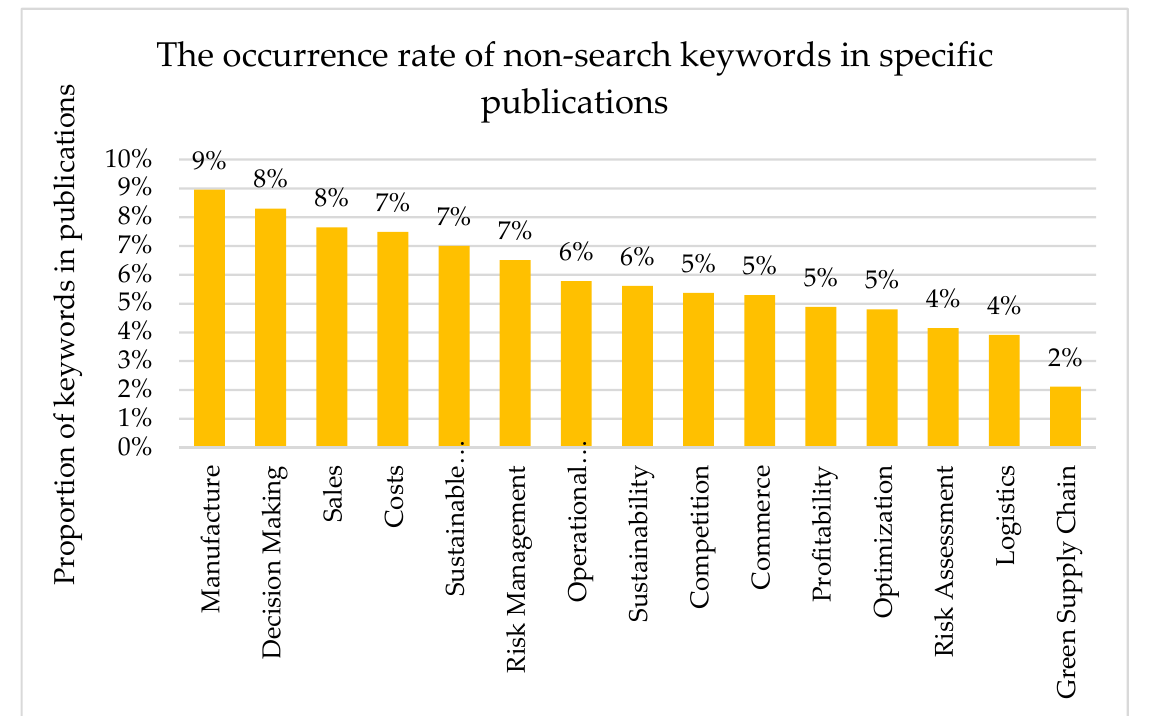
Figure 2. The emergence of disciplines in publications (Source: Self-edit).